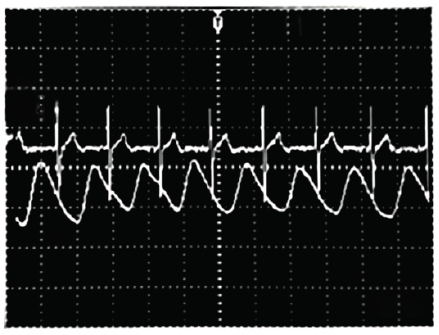
Figure 11. Acquired signals of heartbeat and ECG.